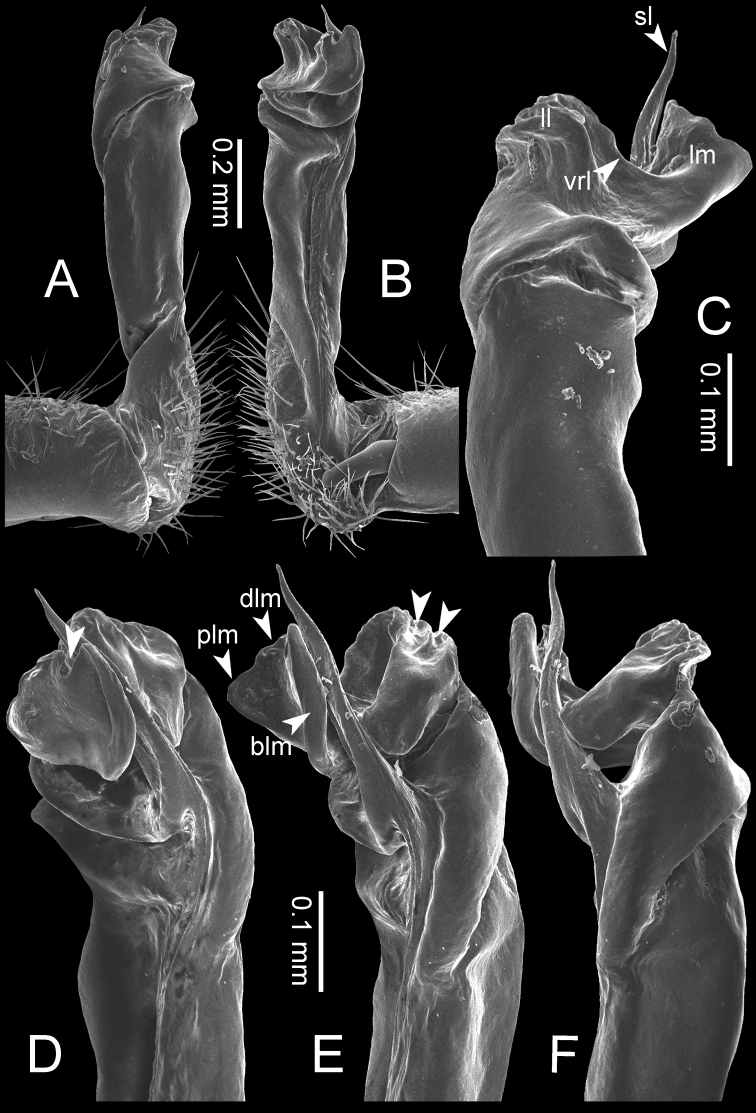

Desmoxytes
flabella sp. n. (paratype) – right gonopod. A lateral view B mesal view C ventral view D subdorsal view (arrows = indentations) E dorsal view (arrows = furrows) F subdorsal view.